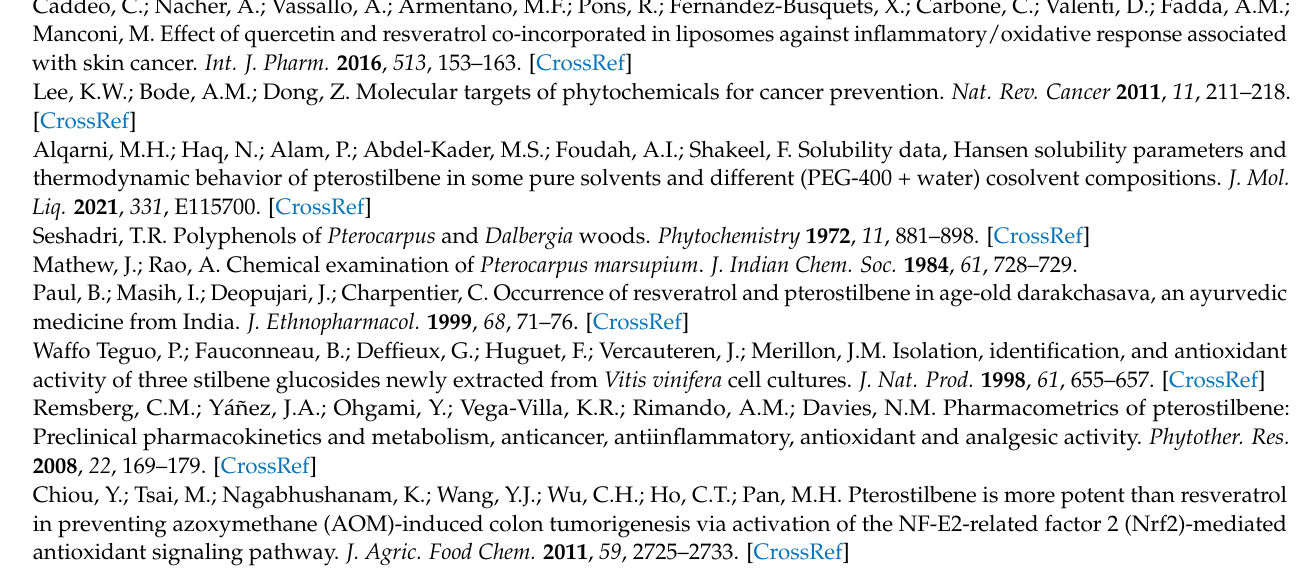
HPTLC techniques (mean ± SD; n =